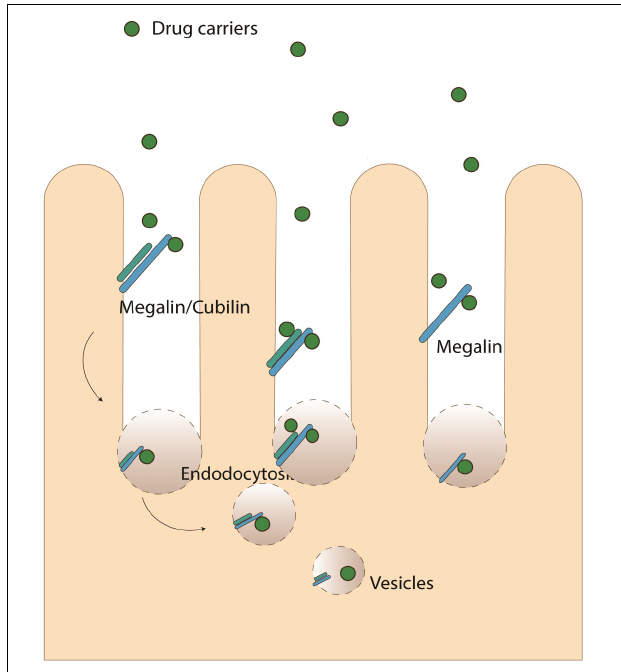
FIGURE 3 | Megalin/cubilin mediated